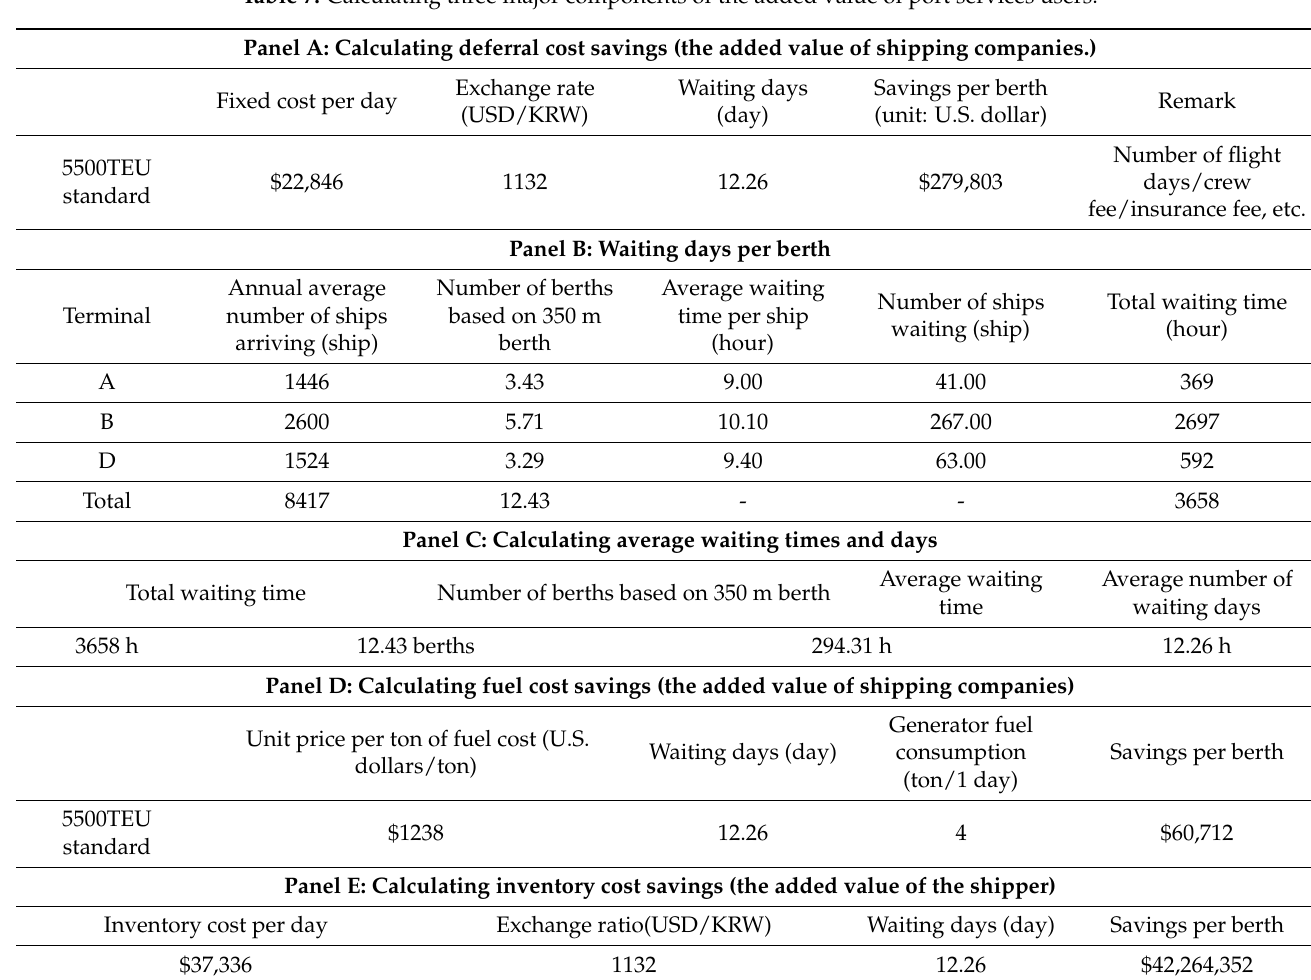
Table 7. Calculating three major components of the added value of port services users. Panel A: Calculating deferral cost savings (the added value of shipping companies.)